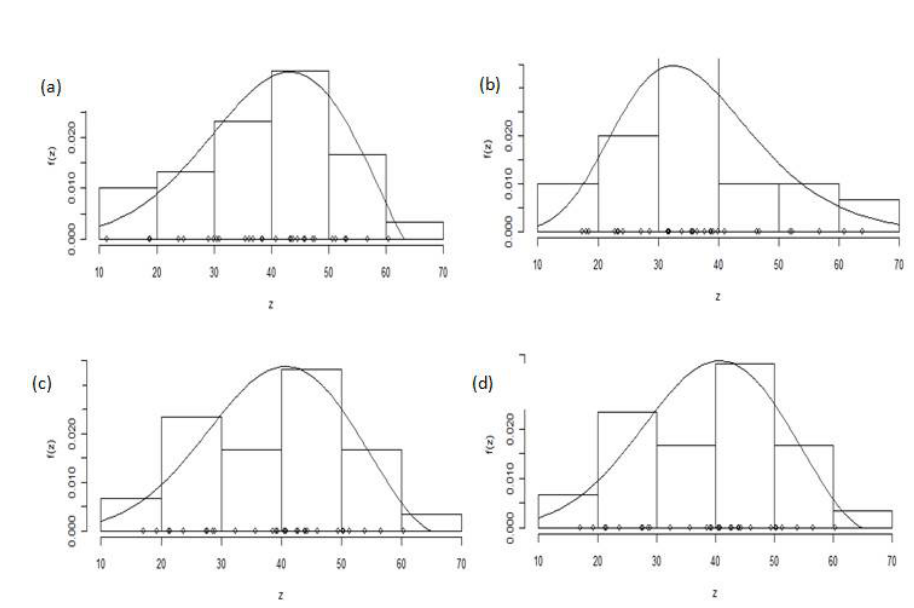
Figure 13. Probability density function distribution (pdf) of (a) control period compared with the future period for (b) 2020s (c) 2050s, (d) 2080s of annual extremes events for A2 scenario.